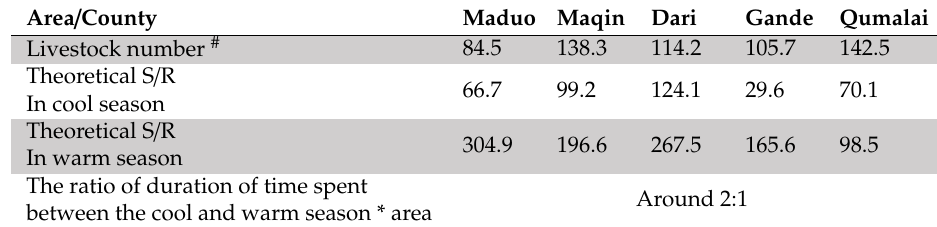
Table 3. Contrast between practical stocking rate (S / R) and theoretical stocking rate of grassland in five counties in Qinghai ( × 10 4 sheep unit)